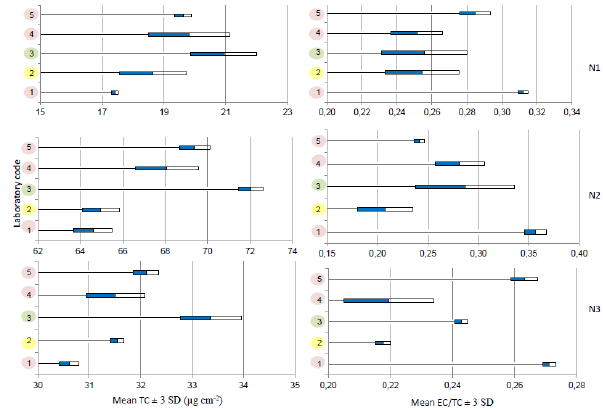
Fig. 1. Statistical distribution for TC (on the left) and the EC/TC ratio (on the right). The width of each box is indicating the standard deviation, while the separation between blue and white bars in the boxes represents the general mean obtained by each laboratory for the different filters. The straight black lines are meaningless and drawn to facilitate the reading only. In the present case, TOT correction was used by each laboratory.